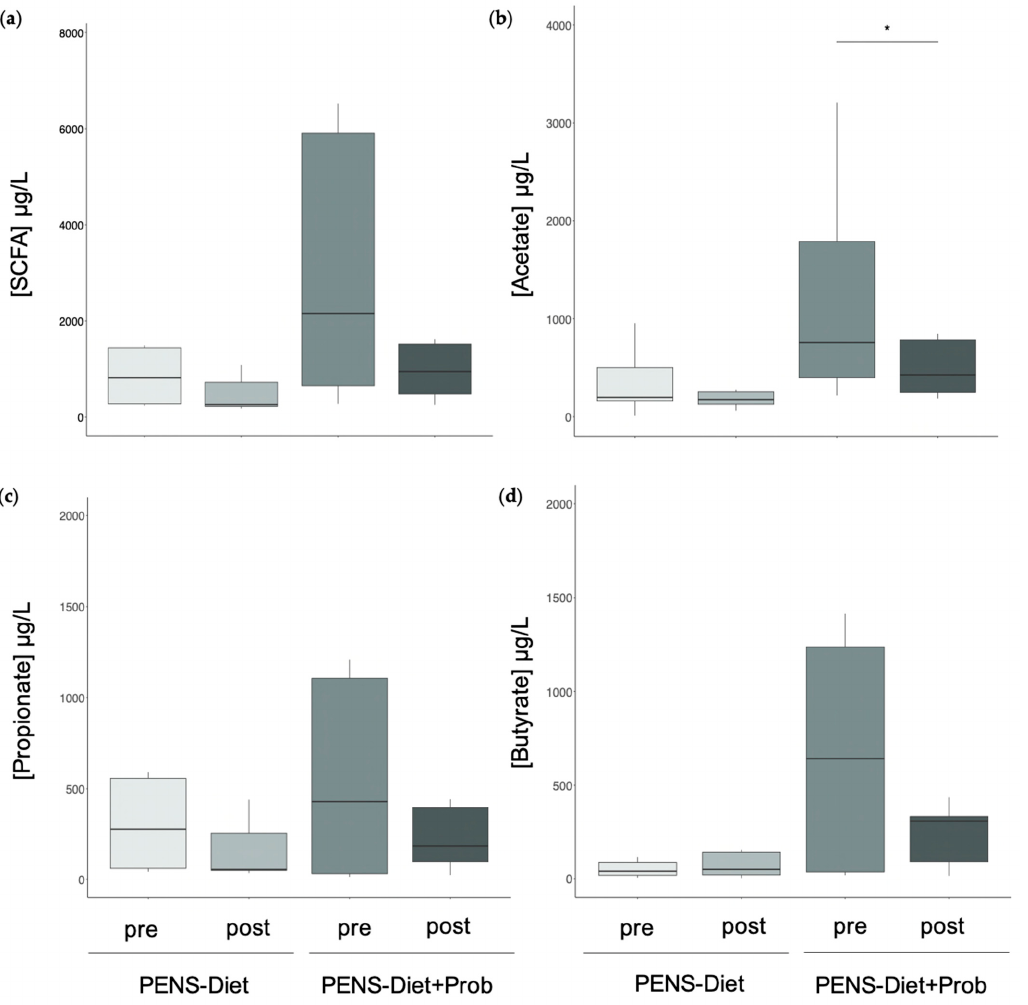
Figure 1. Fecal levels of short-chain fatty acids after PENS-Diet and PENS-Diet+Prob. ( a ) Total levels of main SCFAs, including acetate, propionate, and butyrate, were quantified by HPLC-MS after ten weeks of PENS-Diet and PENS-Diet+Prob. Individual ( b ) acetate, ( c ) propionate, and ( d ) butyrate concentrations are also shown. * p < 0.05 post-treatment vs. pre-treatment.